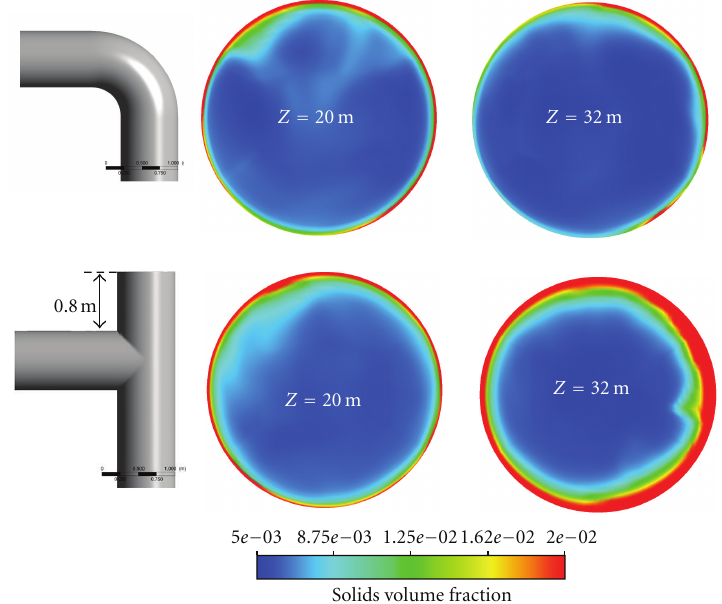
Figure 9: Core-annulus patterns.